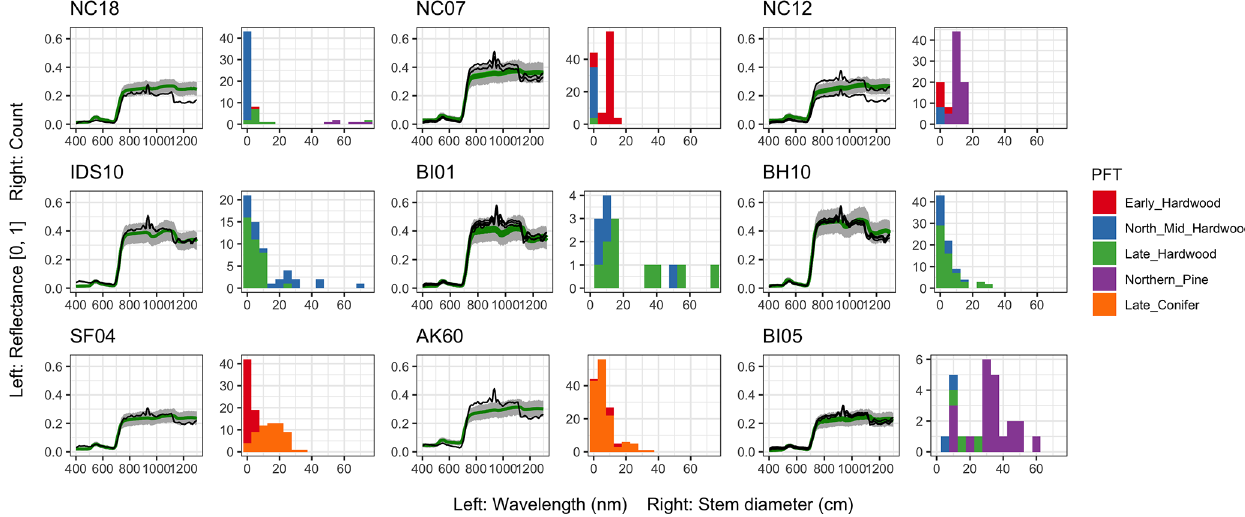
Figure 6. Left: comparison between AVIRIS-observed (black) and EDR-predicted (mean prediction in green; 95% posterior predictive interval in gray) surface reflectance for a geographically (Fig. 1), compositionally, and structurally (Fig. 2) representative sample of sites used in the calibration. Right: histogram of stem DBH by PFT at the corresponding site.